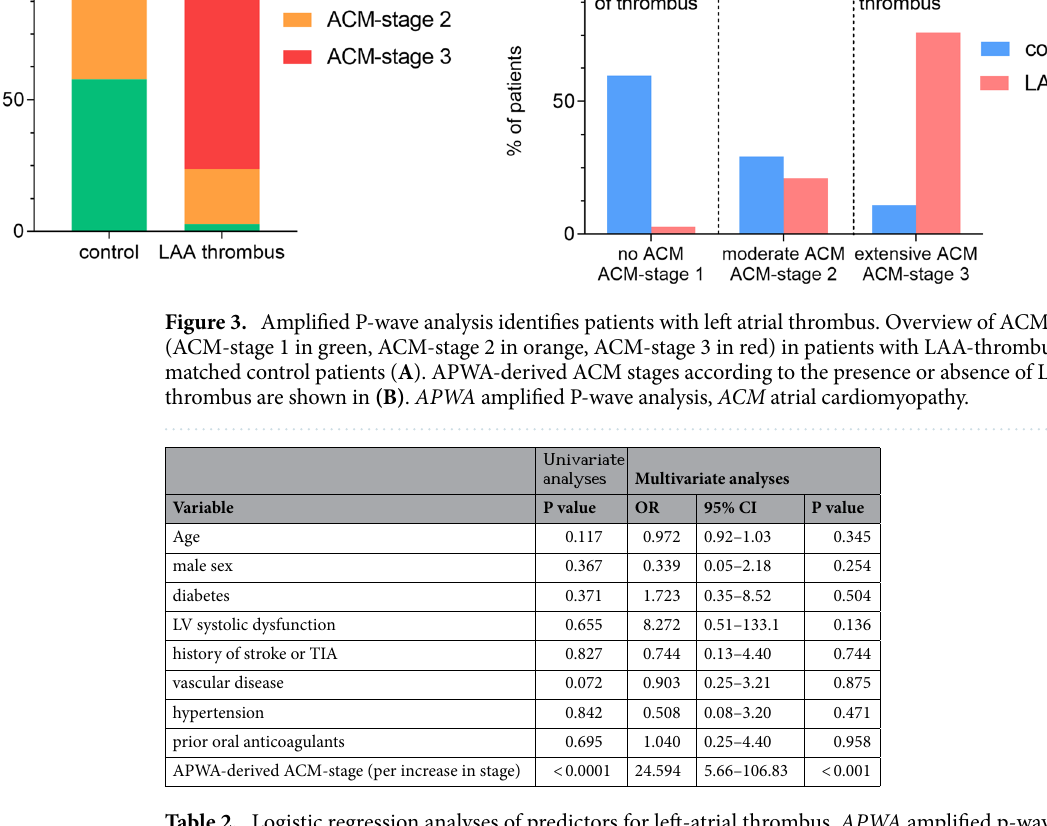
Table 2. Logistic regression analyses of predictors for left-atrial thrombus. APWA amplified p-wave analysis, ACM atrial cardiomyopathy, LV left ventricular, TIA transient ischemic